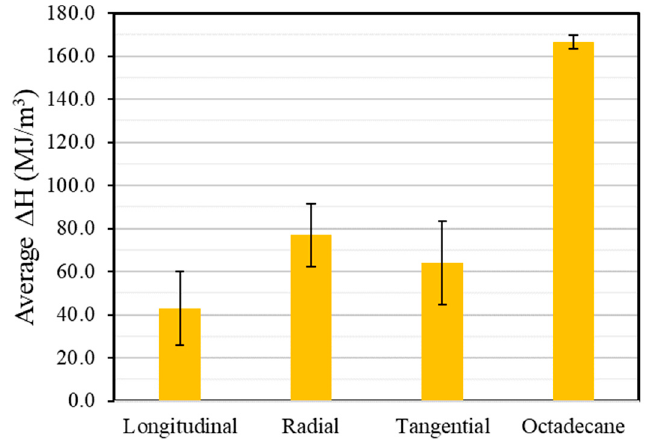
Figure 15. Pinus radiata wood impregnated with octadecane average fusion enthalpy.